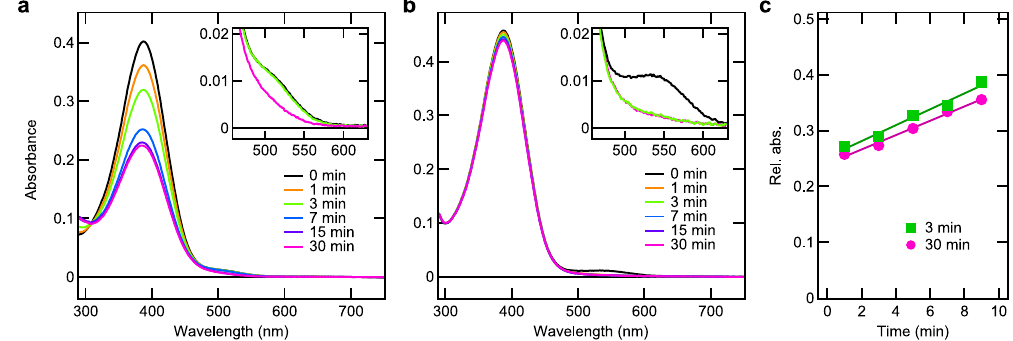
Figure 1. Photoisomerisation of all- trans -retinal by squid retinochrome and spider peropsin. ( a , b ) Absorption spectra of mixtures of all- trans -retinal and squid retinochrome ( a ) or spider peropsin ( b ) before and after illumination for 1, 3, 7, 15, and 30 min. Insets: absorption spectra around λ max of retinochrome ( ≈ 500 nm) and peropsin ( ≈ 540 nm). Note that absorbance of the dark state of retinochrome showed no decrease after illumination for 3 min because it completely regenerated with all- trans -retinal by the time of the measurement after illumination, namely within ≈ 1 min. ( c ) Regeneration processes of the dark state of spider peropsin during dark incubation after illumination for 3 and 30 min. Relative values of absorbance around 540 nm, normalized to that before illumination, are plotted against the time of dark incubation and fitted with linear